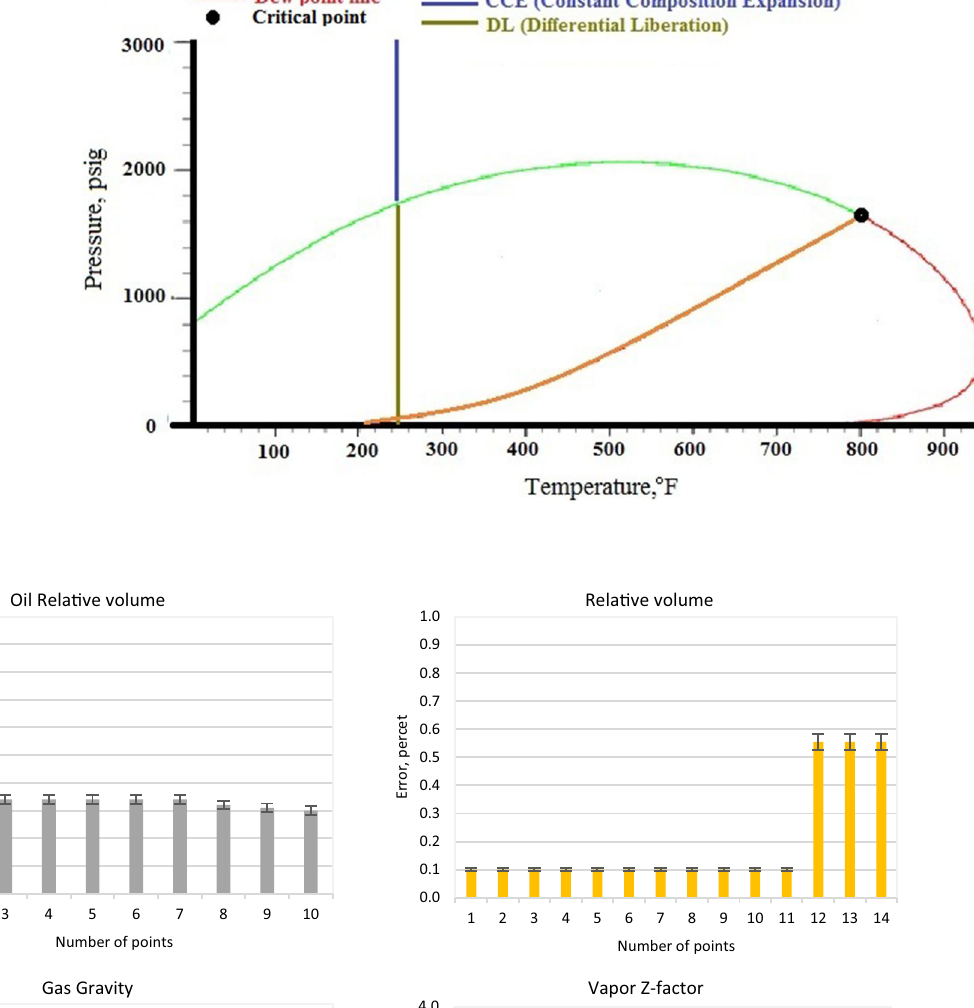
Fig. 1 Phase diagram of S3 reservoir fluid sample using Eclipse PVTi at 246 °F